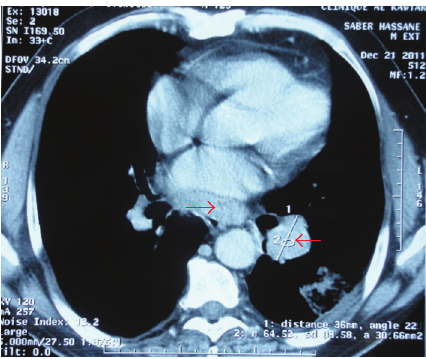
Figure 3: CT scan of the chest cut: extensive mediastinal lymphad- enopathy with a mixed-density lung mass with irregular margins at the left hilum.